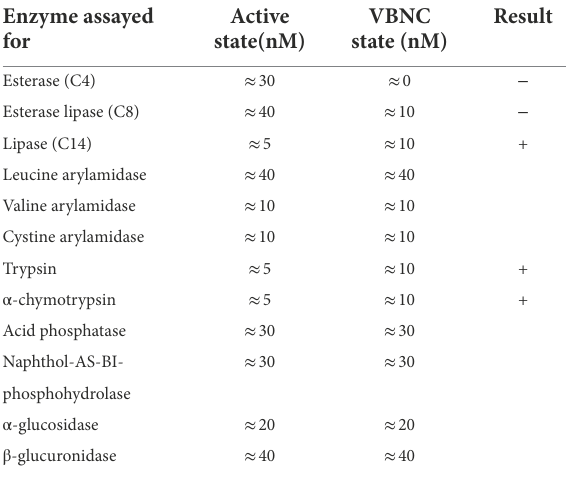
TABLE 1 Detection of extracellular enzyme